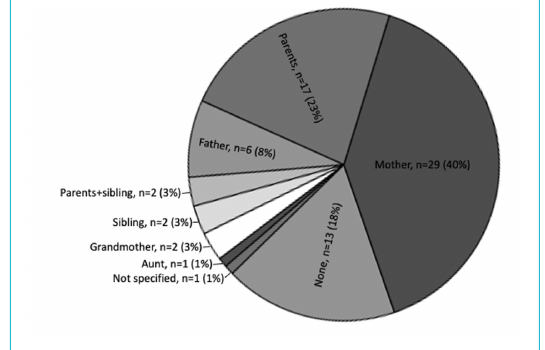
Figure 2: Exposure to known or suspected SARS-CoV-2-infected cases in 73 neonates.